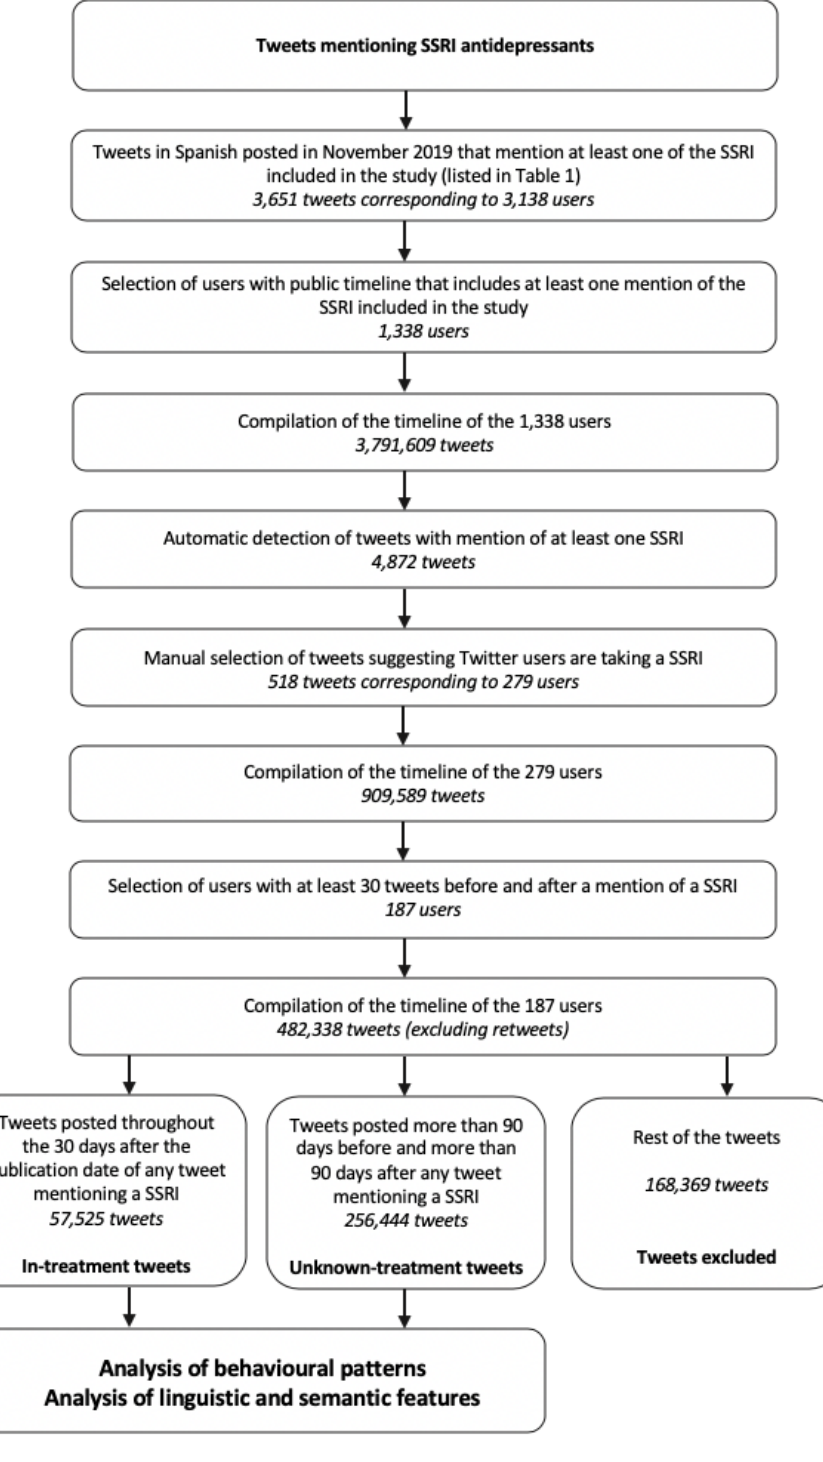
Figure 1. Flow diagram of the study process. SSRI: selective serotonin reuptake